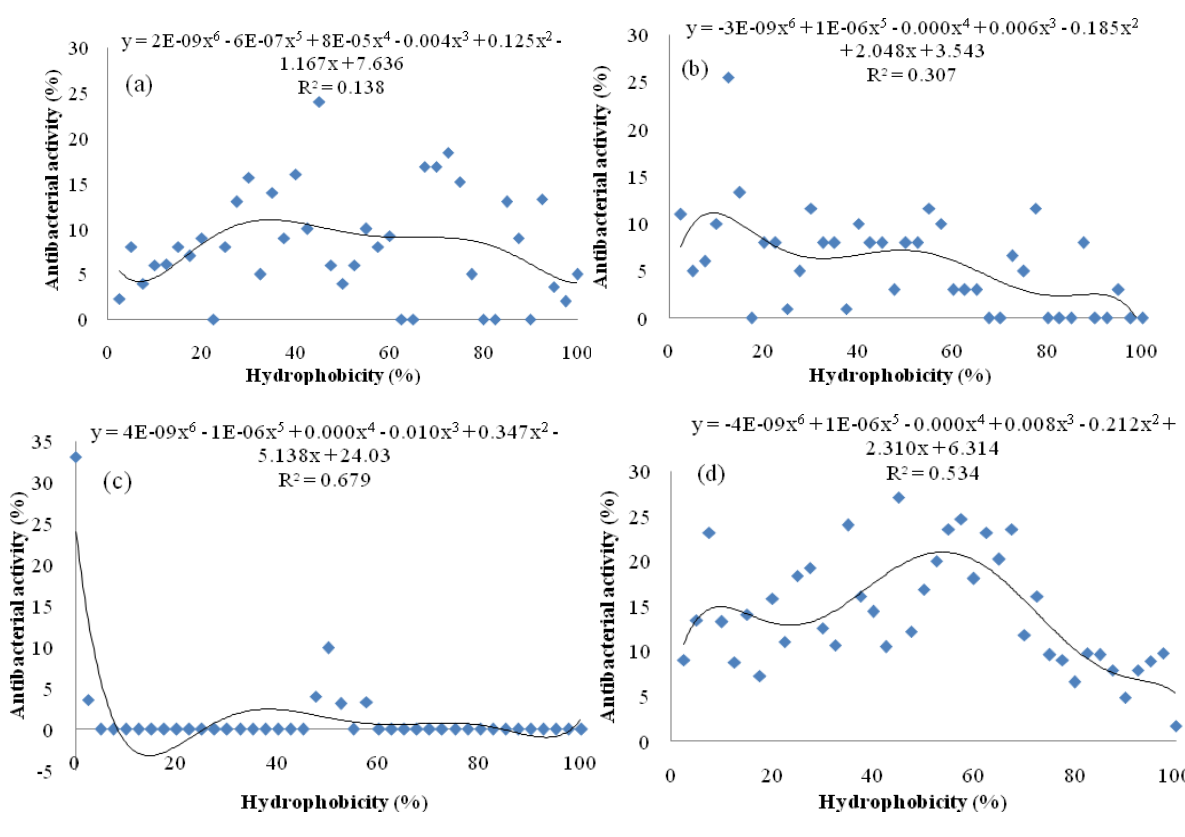
Figure 7. Effect of peptide hydrophobicity (%) on its antibacterial activity (%). Function of hydrophobicity (%) versus antimicrobial activity: ( a ) Pseudomonas sp.; ( b ) P. aerogeniosa ; ( c ) S. aureus ; and ( d ) E. coli